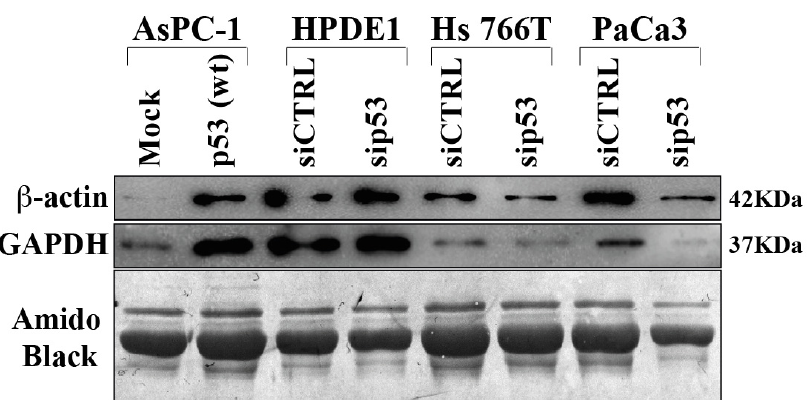
Figure 4. Immunoblot validation of p53-dependent hyposecreted proteins. p53-null AsPC-1 cells were transiently transfected with WTp53 or mock control plasmids, Hs 776T and PaCa3 WTp53- PDAC cell lines and HPDE1 human pancreas non-tumor cells were transiently transfected with siP53 to downregulate TP53; a scramble siRNA (siCTRL) was used as a control. A total of 48 h after transfection, cells were washed and further incubated for 22 h in serum-deprived media. Secreted proteins were precipitated overnight and p53-dependent GAPDH and ß-Actin protein expression was confirmed by immunoblot. Amido black staining was used as loading control.